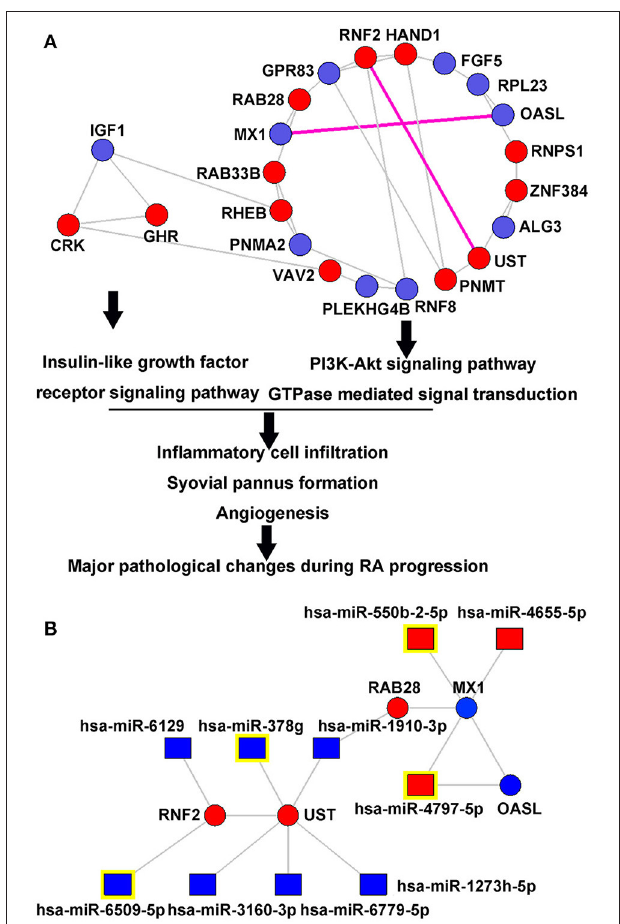
FIGURE 3 | miRNA-mediated gene signal transduction network . (A) Two functional modules in the miRNA-mediated gene signal transduction network. The miRNA-mediated gene signal transduction network was divided into two functional modules containing 19 and 3 nodes, respectively. The first module was significantly associated with PI3K-Akt signaling pathway ( P = 0.02) and GTPase mediated signal transduction ( P = 0.003), and the second one was involved into Insulin-like growth factor receptor signaling pathway ( P = 0.02), which can potentially regulate the major pathological changes during RA progression. (B) Upstream differentially expressed miRNAs that regulate the interactions of MX1-OASL and RNF2-UST. Red and blue square nodes respectively refer to the upregulated and downregulated miRNAs in the responder group compared to the non-responder group. Red and blue circle nodes respectively refer to the upregulated and downregulated mRNAs in the responder group compared to the non-responder group. Purple edges refer to the gene-gene interaction with the highest edge-betweenness, suggesting their crucial roles in transferring signals. miRNA nodes with yellow marks refer to the most differentially expressed miRNAs that regulate MX1, OASL, RNF2, and UST, respectively.